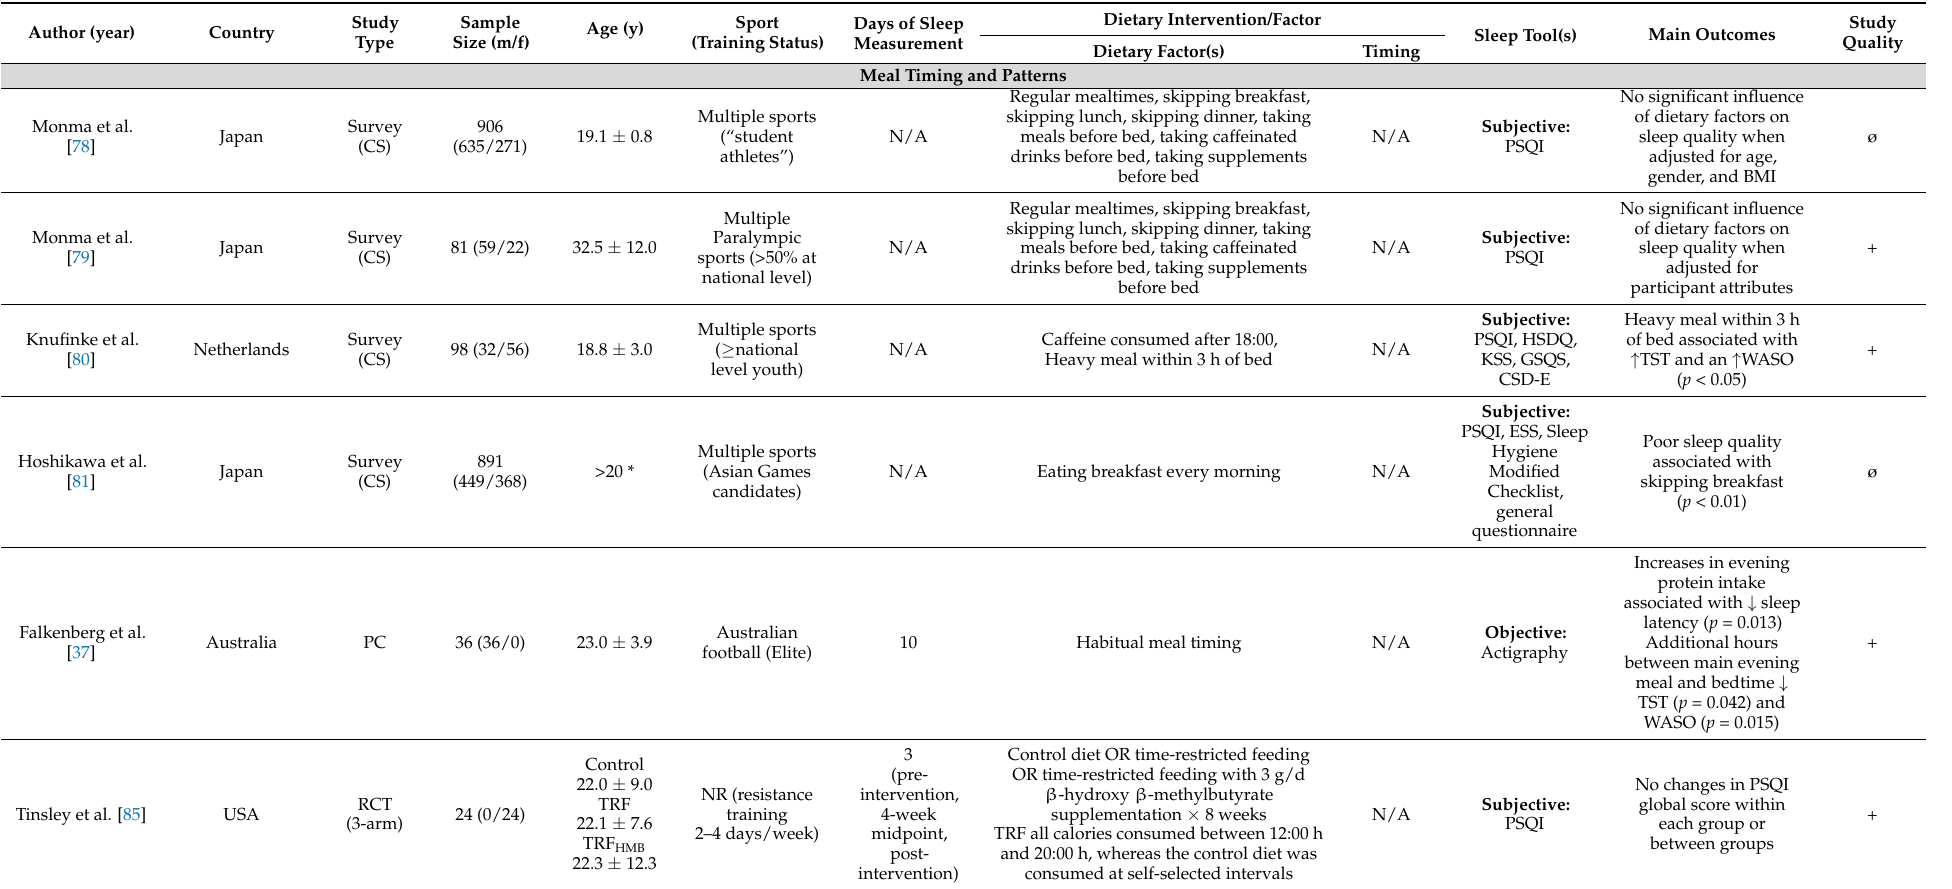
Table 4. Studies investigating the influence of dietary patterns on the sleep of athletically trained